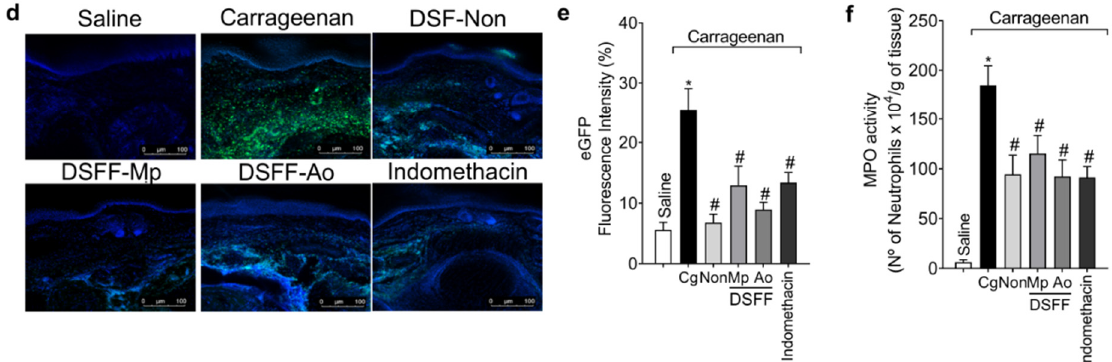
Figure 3. Evaluation of edema and leukocyte recruitment in carrageenan paw inflammation. DSF-Non, DSFF-Mp, and DSFF-Ao (30 mg/kg) extracts inhibits ( a ) paw edema, ( b ), and ( c ) histopathology (leukocyte infiltration, scale bars indicate 50 μ m), ( d , scale bars indicate 100 μ m) and ( e ) eGFP + cells migration, and ( f ) MPO activity in the paw tissue. Indomethacin (5 mg/kg) was used as a positive control drug. Paw edema was evaluated 1, 3, and 5 h after and leukocyte recruitment experiments were conducted 5 h after carrageenan i.pl. injection. Results are expressed as mean ± SEM of six mice per group per experiment and are representative of two independent experiments. * p < 0.05 vs. saline group; # p < 0.05 vs. carrageenan group.